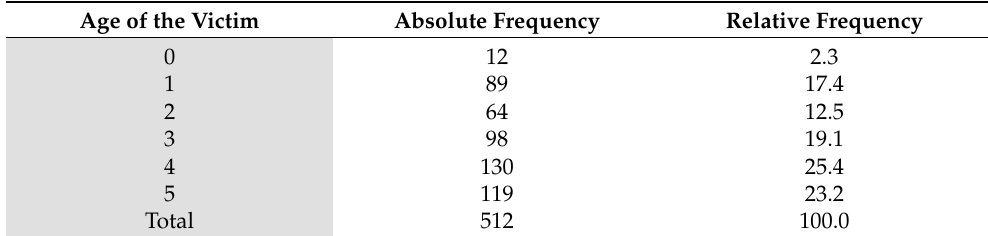
Table 1. Age of the victim. Age of the Victim Absolute Frequency Relative